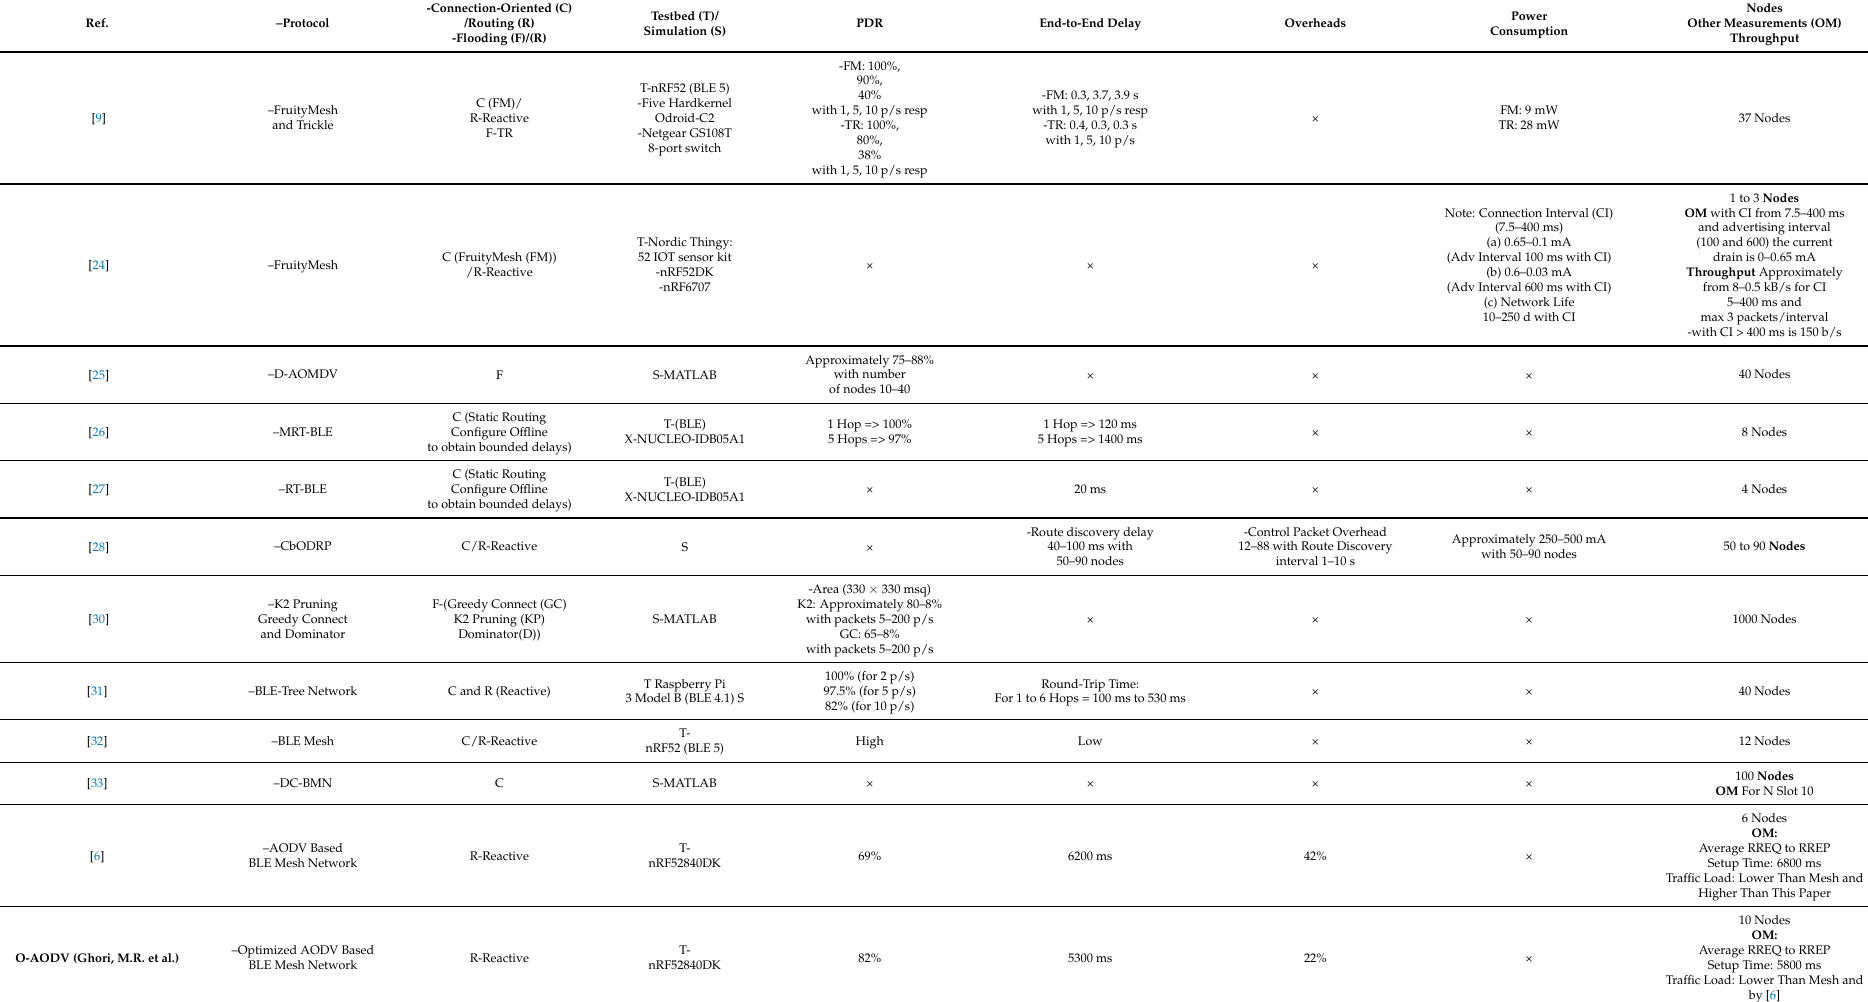
Table 1. Summary of various pure BLE-based mesh protocols.